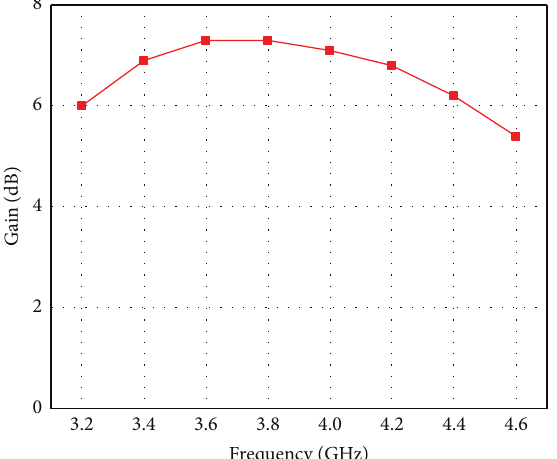
Figure 10: Measured and simulated AR. (a) 3.6 GHz and (b) 4.4 GHz.